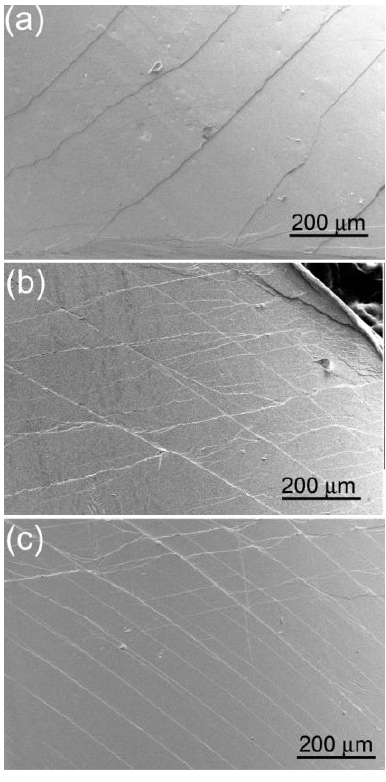
Ni P with a plastic strain of 1.5%; 40 40 20 Ni Si P with a plastic strain of 3.2%; 40 40 4 16 Ni Si P with a plastic strain of 40 40 3 17